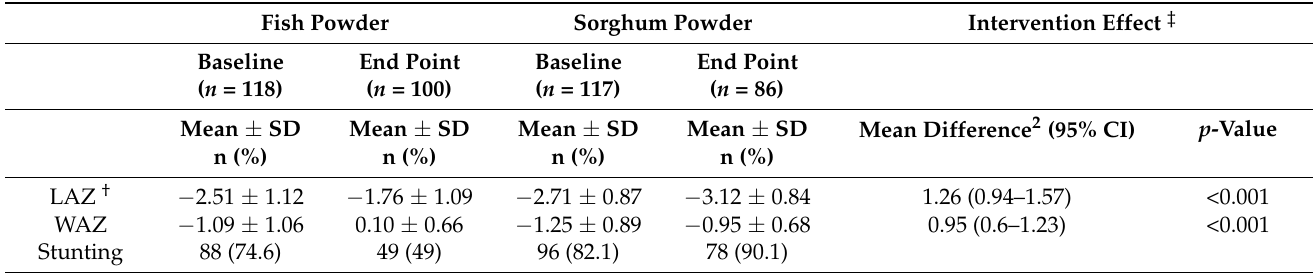
Table 5. Infants growth for the study duration and the effect of the